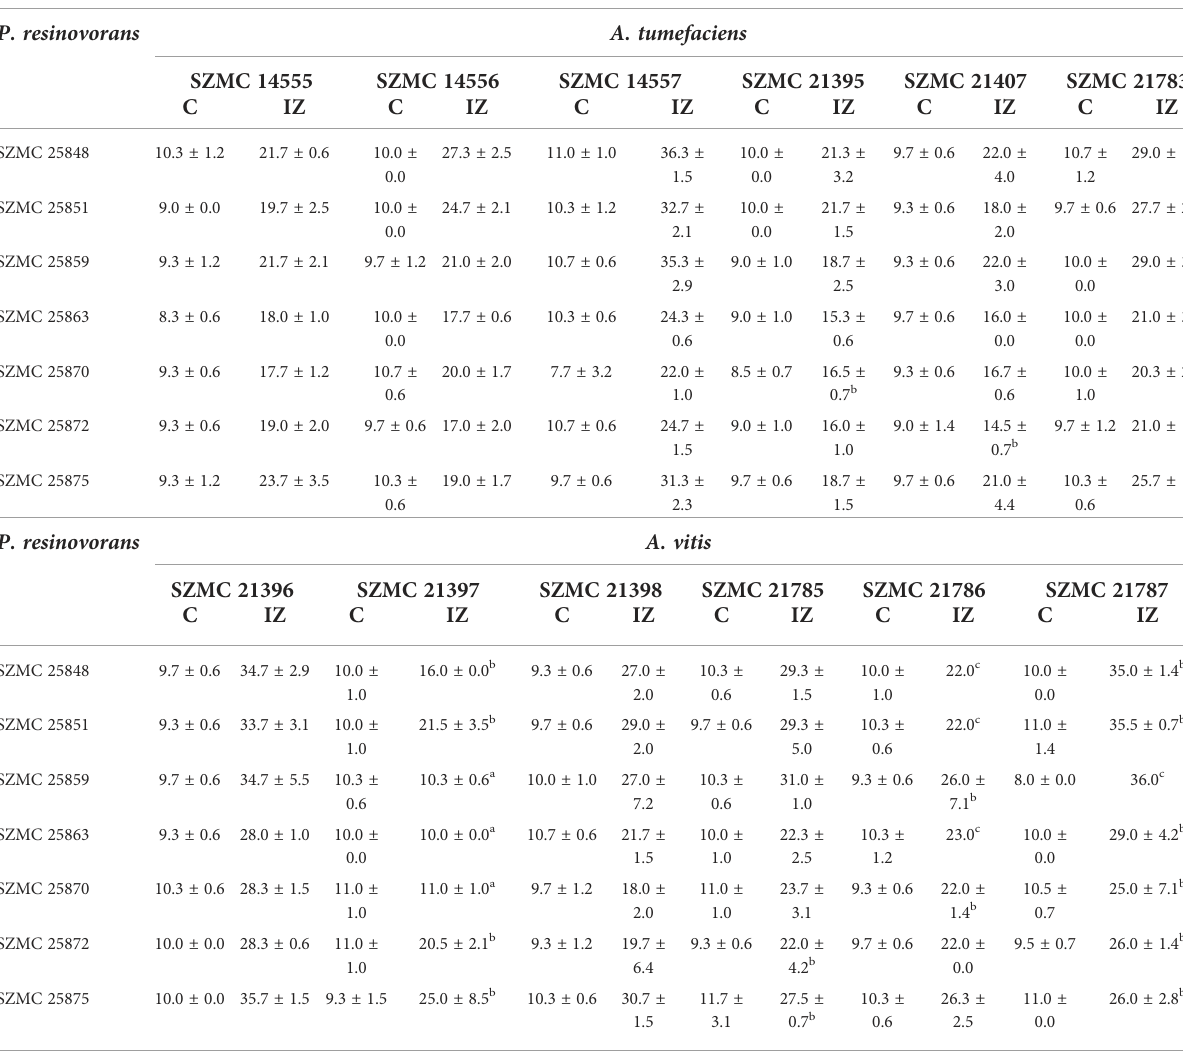
TABLE 3 Colony diameter (C, mm) and colony + inhibition zone diameter (IZ, mm) values of 7 P. resinovorans isolates on susceptible A. tumefaciens and A. vitis